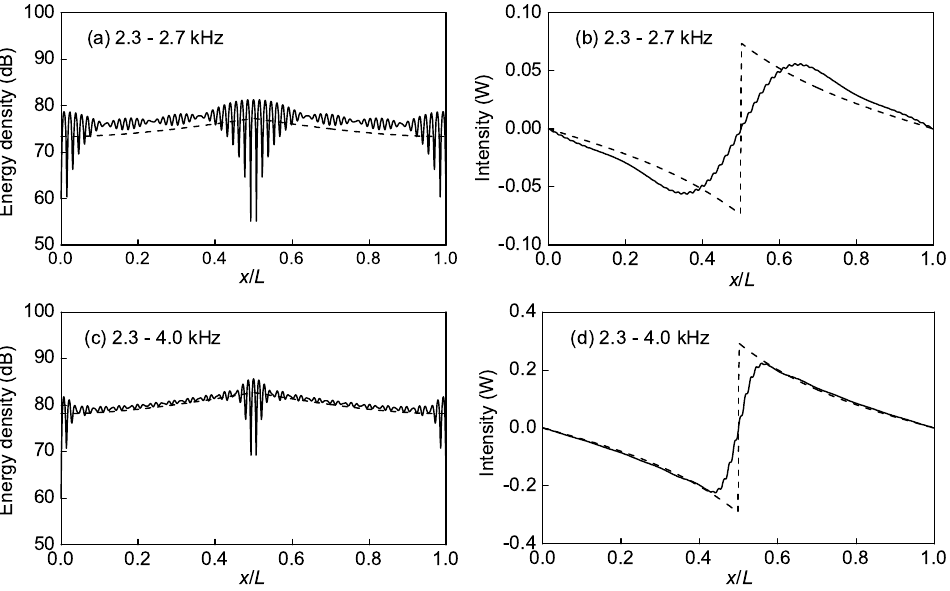
Fig. 5. Response of the beam when a concentrated force is applied at the beam center. —, exact solution from modal analysis; - - -, random EFA approximation. (a), (c): energy density distribution for different bandwidth; (b), (d): intensity for different bandwidth. The reference energy is 1 × 10 − 12 J m − 1